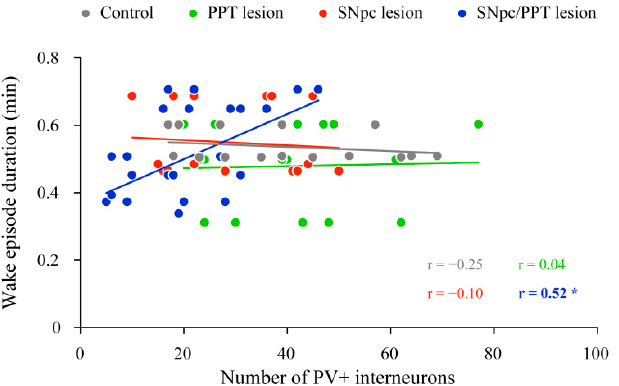
Figure 4. Functional coupling between the altered number of PV+ interneurons within DG and Wake episode duration in the distinct rat models of PD neuropathology. The significant positive correlation between the number of PV+ interneurons in DG and Wake episode duration in the hemiparkinsonian rats PD cholinopathy (SNpc/PPT lesion; n = 7) in contrast to no significant correlations in the control rats (Control; n = 3), the rats with PD cholinopathy (PPT lesion; n = 3) and the hemiparkinsonian rats (SNpc lesion; n = 3). Bold numbers with * indicate the statistically significant correlations at p ≤ 0.05.